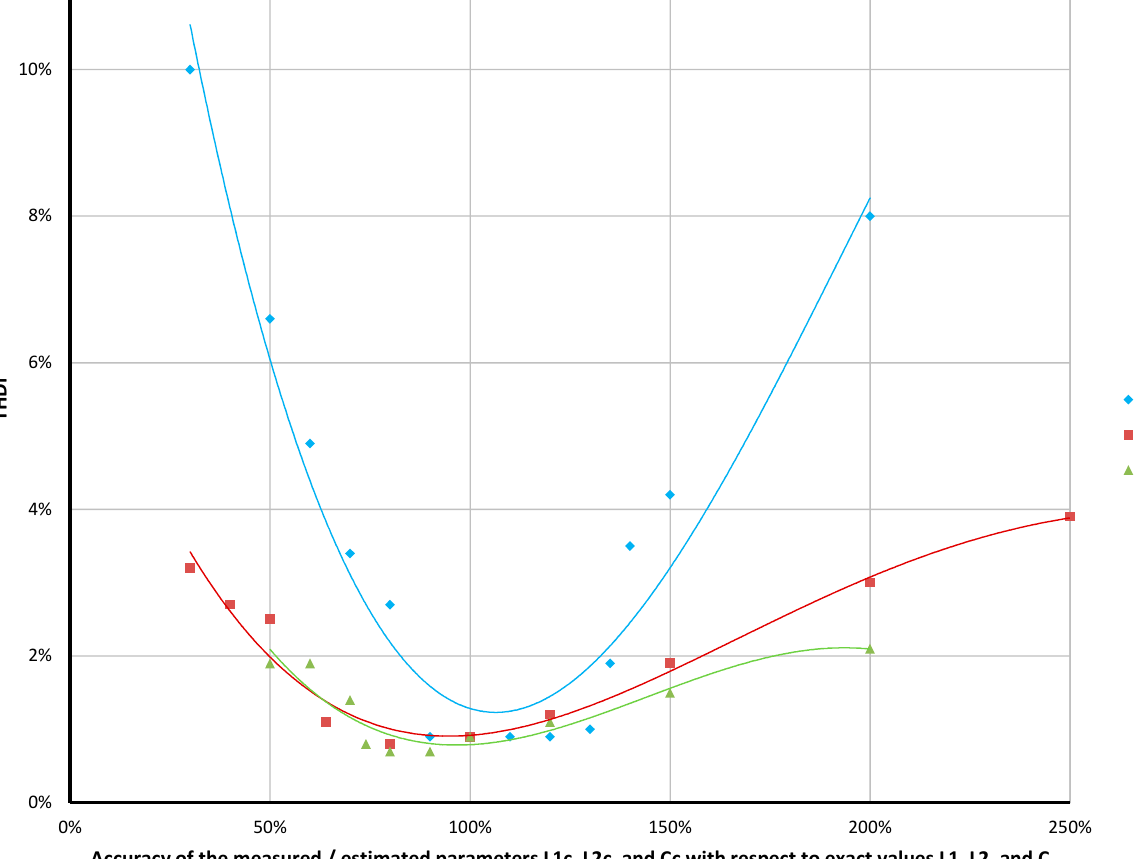
Figure 11. THD i value changes as a function of the accuracy of LCL circuit parameter identification.